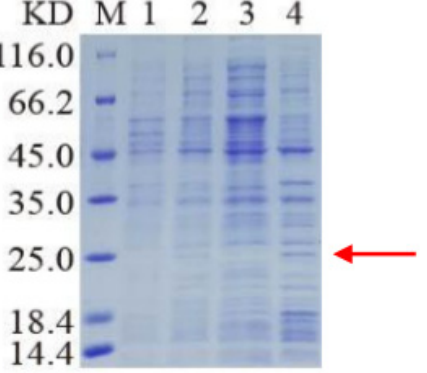
indicates that the target protein was mainly present in the precipitate.